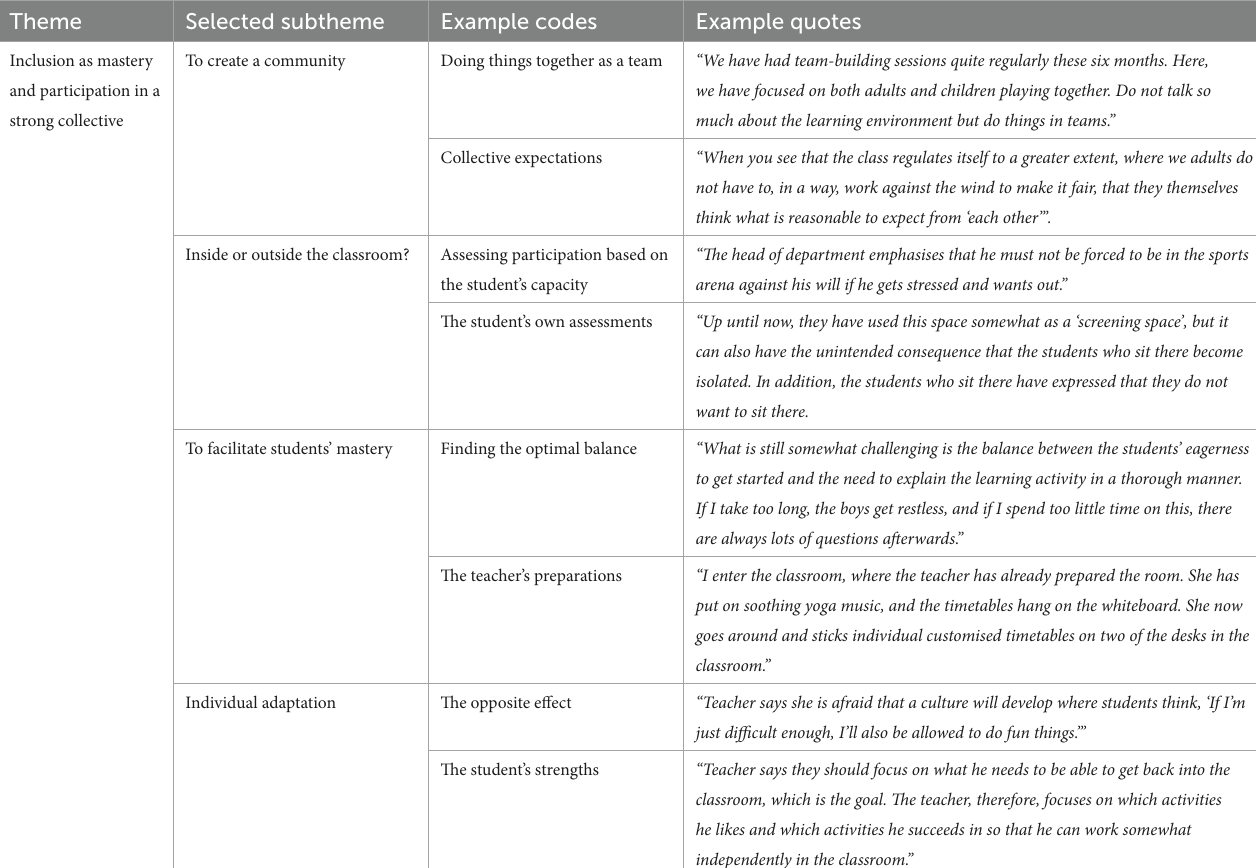
TABLE 2 Themes, subthemes, codes and example